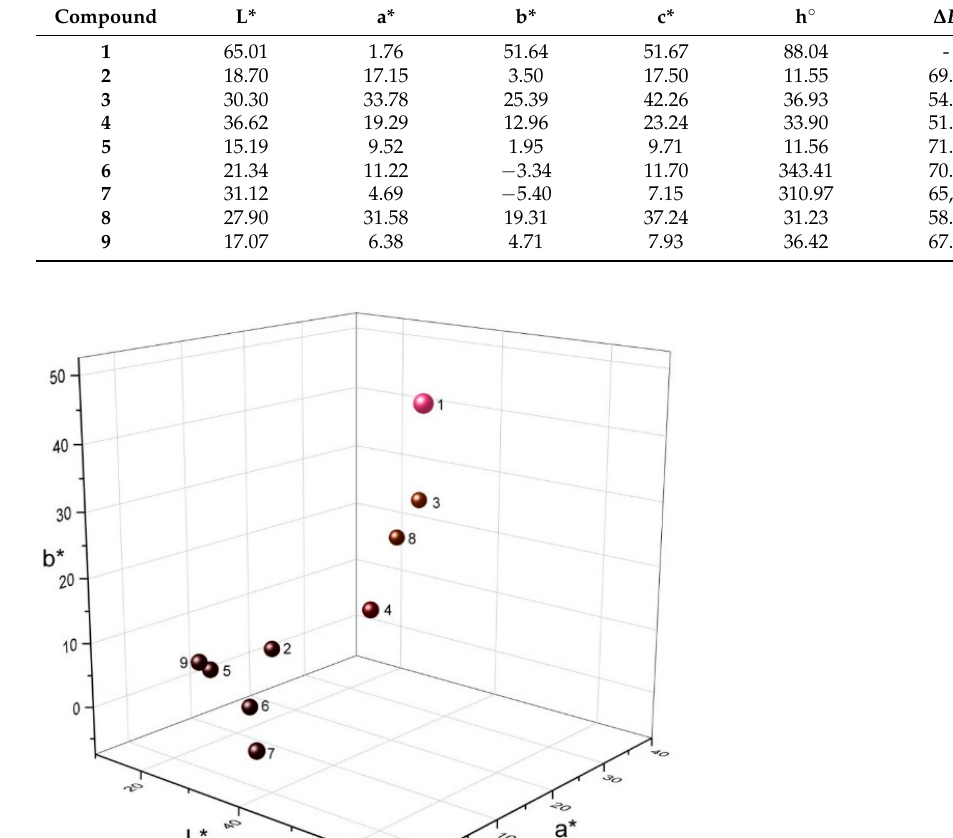
Table 2. Colorimetric properties of thio derivatives of lawsone.